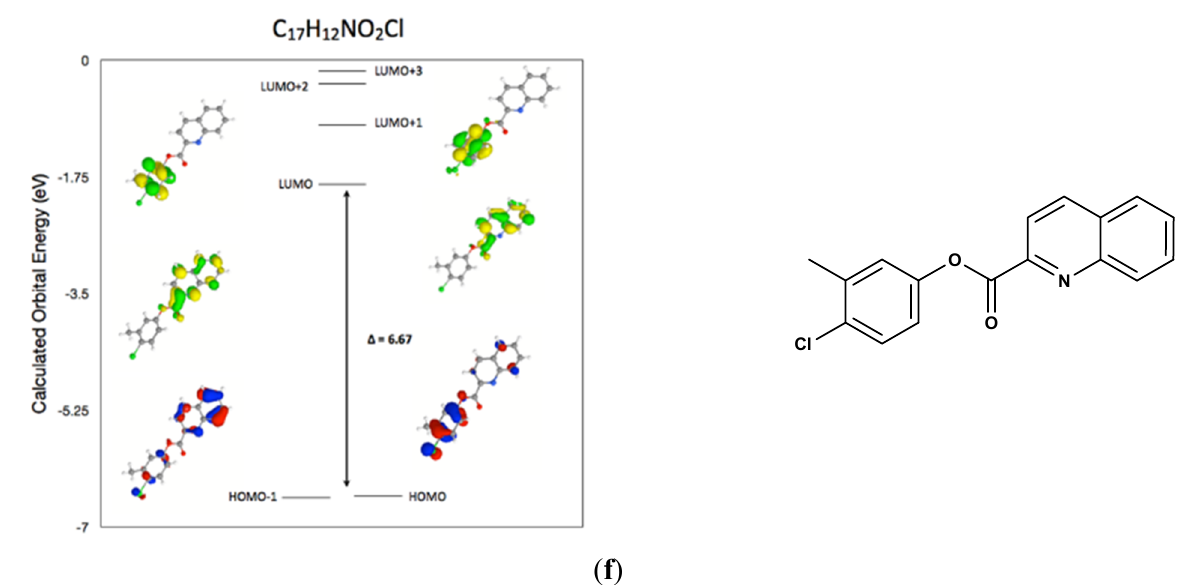
Figure 5. Calculated frontier molecular orbitals for compounds III – VIII . ( a ) calculated frontier molecular orbitals for C 17 H 13 NO 2 ( III ) (Reprinted with permission from